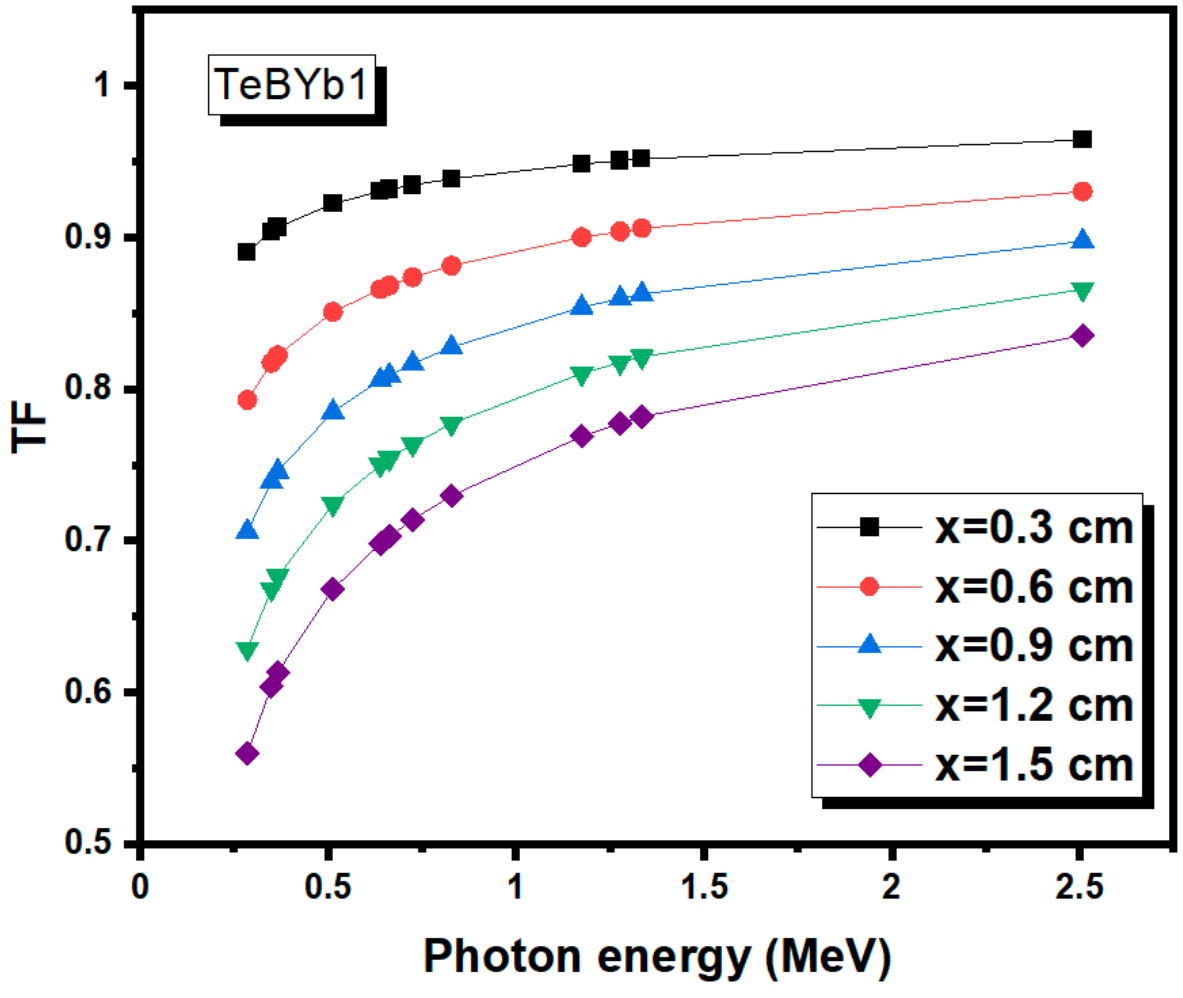
Figure 4. The transmission factor for TeBYb1 as a function of the energy at different thicknesses. The TF of TeBYb5 was plotted against energy at various thicknesses in Figure 5. The same five thicknesses and energy range were used as in the previous figure. Similar trends can be observed between this figure and the last. For example, TF decreases as the thickness of the sample increases. At 2.506 MeV, the TF is equal to 0.950 for a thickness of 0.3 cm, 0.858 for a thickness of 0.9 cm, and 0.774 for a thickness of 1.5 cm. In addition, for any